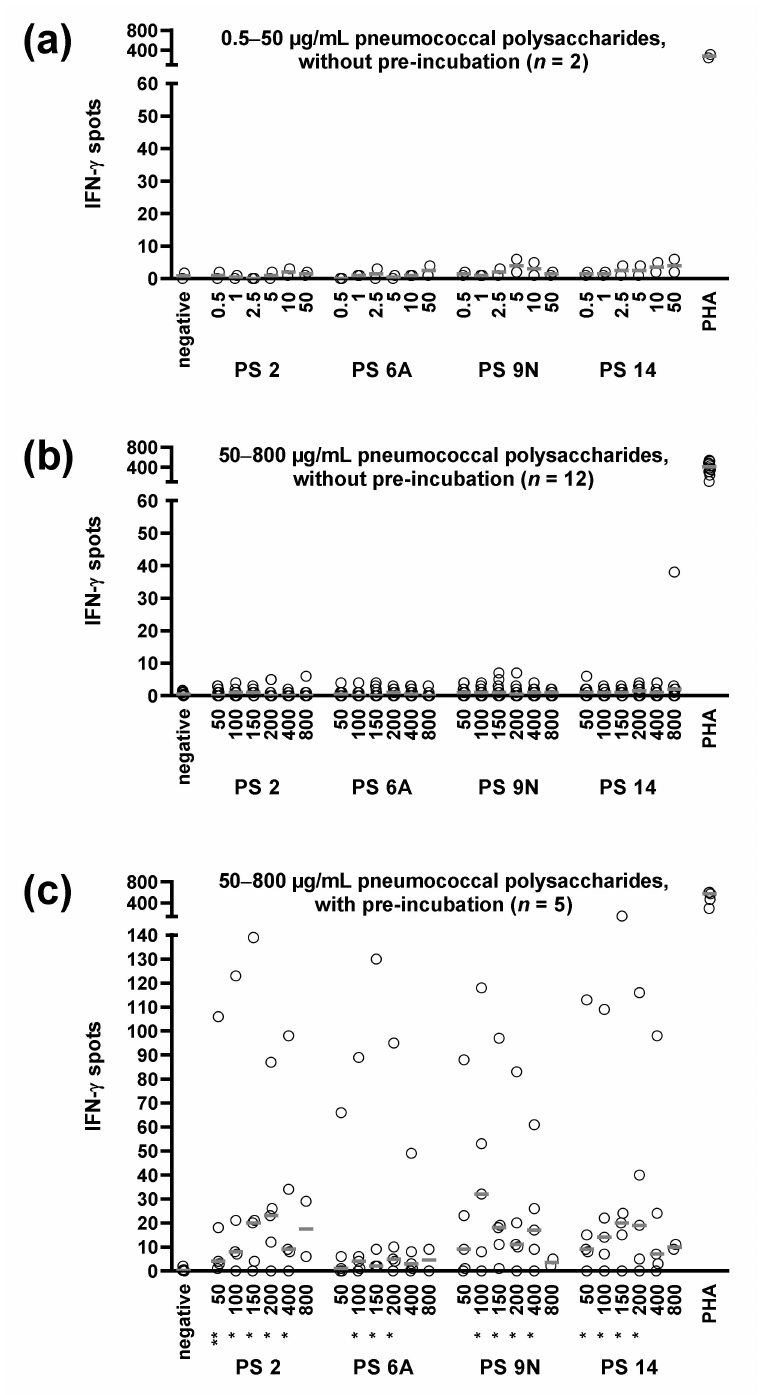
Figure 1. Optimization of ELISpot conditions to determine specific cellular immunity against S. pneumoniae . ( a ) The titration of low concentrations of the pneumococcal polysaccharides of the serotypes (PS) 2, 6A, 9N, and 14 (0.5–50 µ g/mL), using no pre-incubation step, i.e., the cells were directly incubated in ELISpot plates (without pre-incubation). ( b , c ) Results after stimulation with higher concentrations of the pneumococcal polysaccharides (50–800 µ g/mL), either without ( b ) or with ( c ) overnight pre-incubation in U bottom plates. In all cases ( a – c ), we tested kidney transplant recipients after pneumococcal vaccination. Median values are indicated by grey horizontal lines. Positive control experiments were performed with the T-cell mitogen phytohemagglutinin (PHA). Results as displayed in ( b , c ) were compared by Mann–Whitney test. * p < 0.05, ** p <